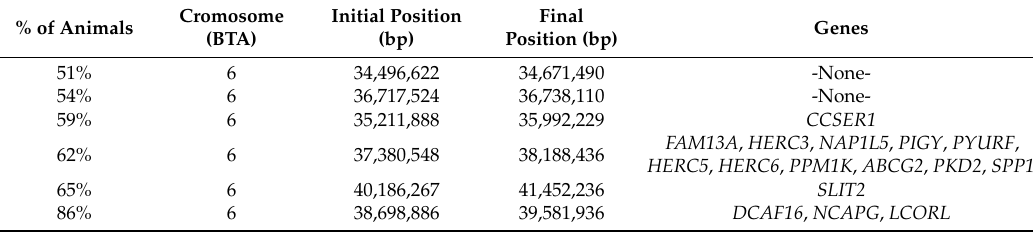
Table 3. Regions of homozygosity shared with more than 50% of the